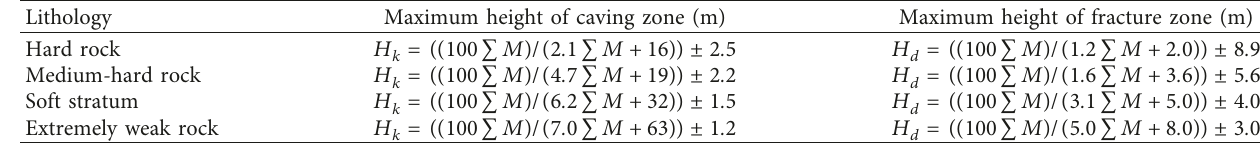
Table 4: Traditional empirical calculation formula of collapsed and fractured zone height.